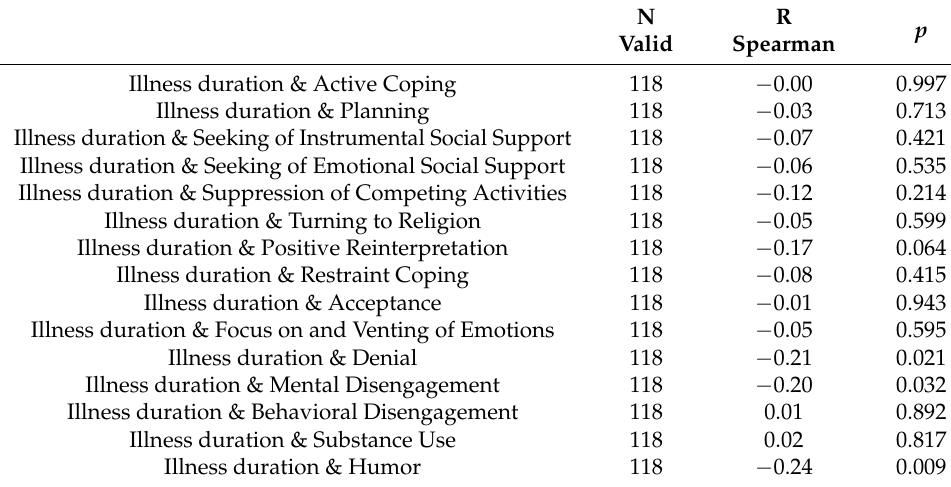
Table 4. Duration of illness versus stress coping